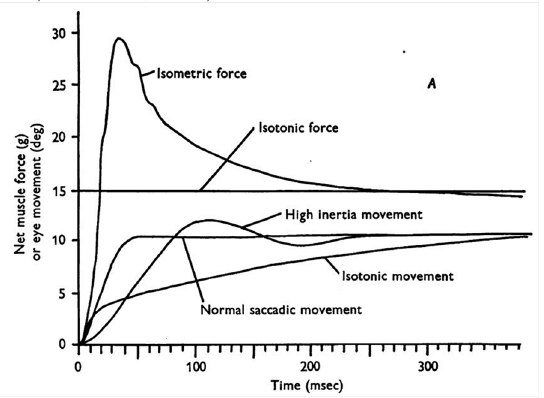
Figure 1. The time courses of isometric, isotonic, high inertia, and normal experiments for a 10° saccade super-imposed. Part B of this Figure (not shown) shows the innervation used. From (Robinson, 1964).